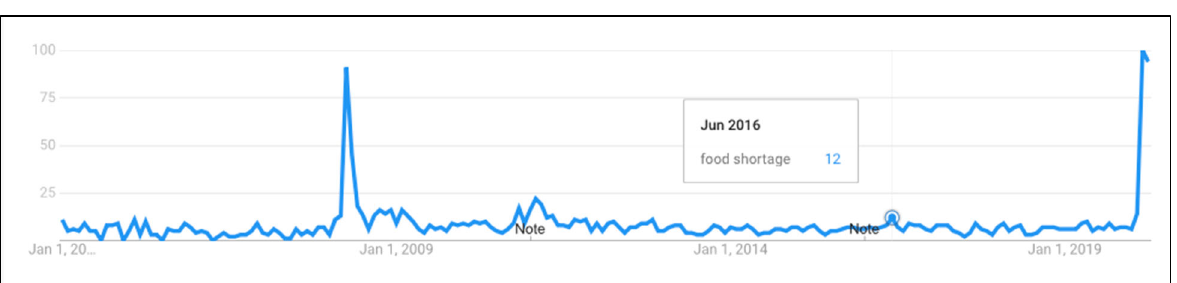
Figure 1c. The Long View of Search Interest in Food Shortage (2004–2020)